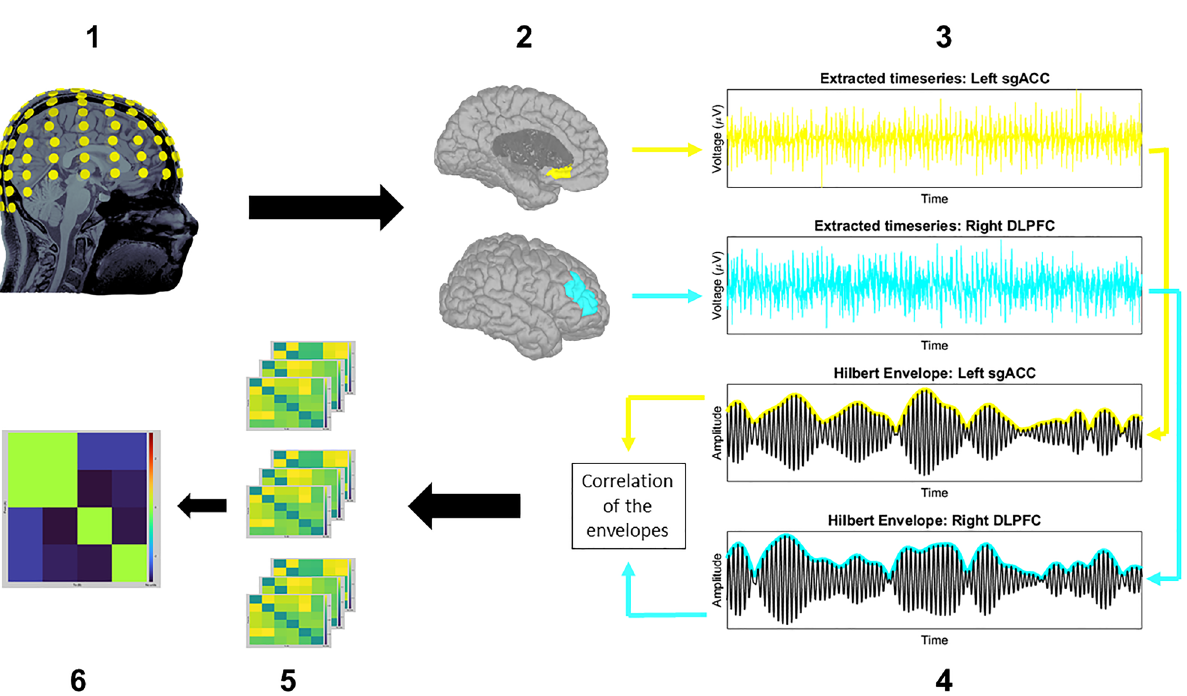
Figure 2. Estimating EEG source-space functional connectivity with the orthogonalized Amplitude Envelope Correlation method. The computation and statistical evaluation of orthogonalized Amplitude Envelope Correlations can be described in six steps: The EEG resting state timeseries data were transformed from sensor- space to source-space using the Minimum Norm source estimation method ( 1 ). Hypothesis driven regions of interest (ROIs) were selected from the USCBrain atlas ( 2 ) and their timeseries extracted ( 3 ) so that predefined band-pass filters together with an orthogonalization procedure could be applied. A Hilbert Transform was subsequently used to generate the power envelopes of these band-pass filtered signals ( 4 ). Correlations were then calculated between the power envelopes of different ROIs for each time sample. The average of these correlations was taken for each ROI pair which produced connectivity matrices for each frequency band of interest per subject ( 5 ). Non-parametric permutation tests were then performed, resulting in statistical maps that were thresholded using the false discovery rate ( 6